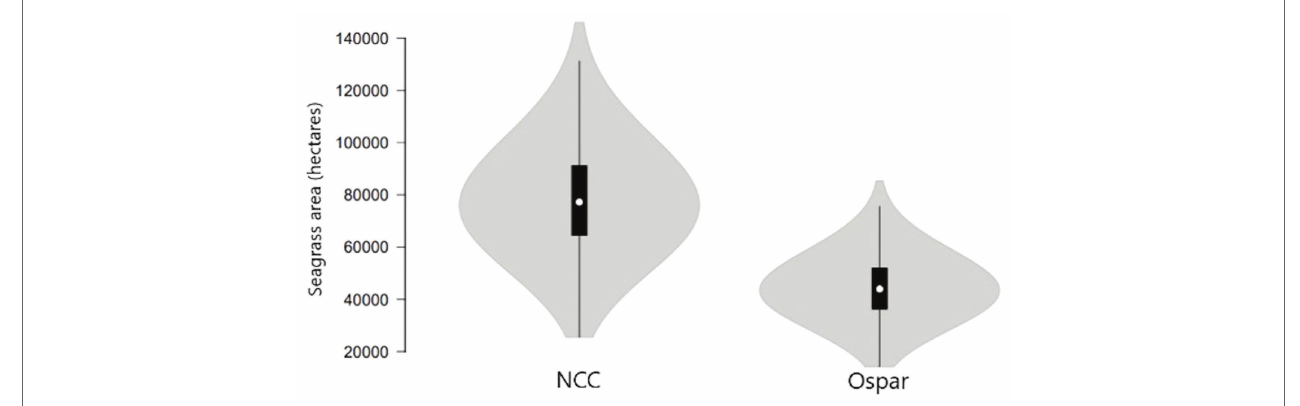
FIGURE 4 | Modelled maximum seagrass area extent in mainland Britain from the NCC report (69) and the OSPAR dataset. Error bars indicate 95%